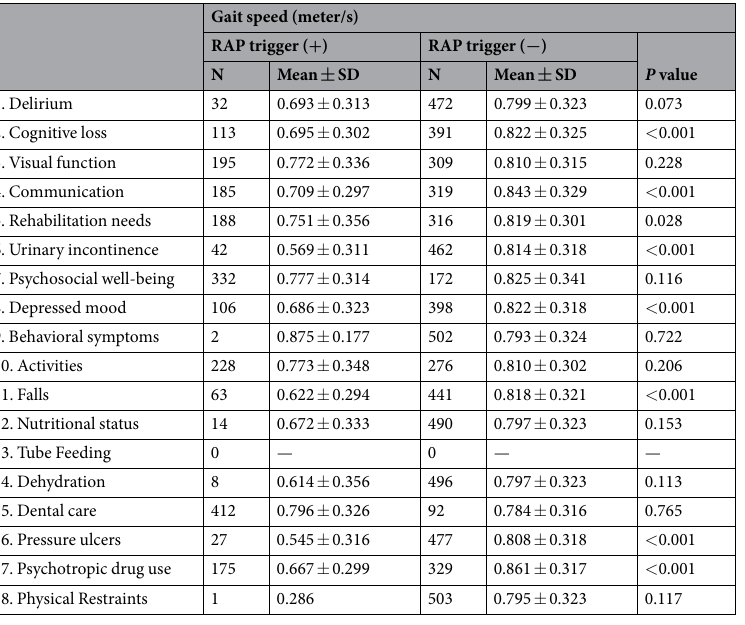
Table 4. Comparisons of mean gait speed between residents with individual RAP triggers. Mean gait speed for total 504 subjects: 0.794 ± 0.324 meter/s. RAP: Resident assessment